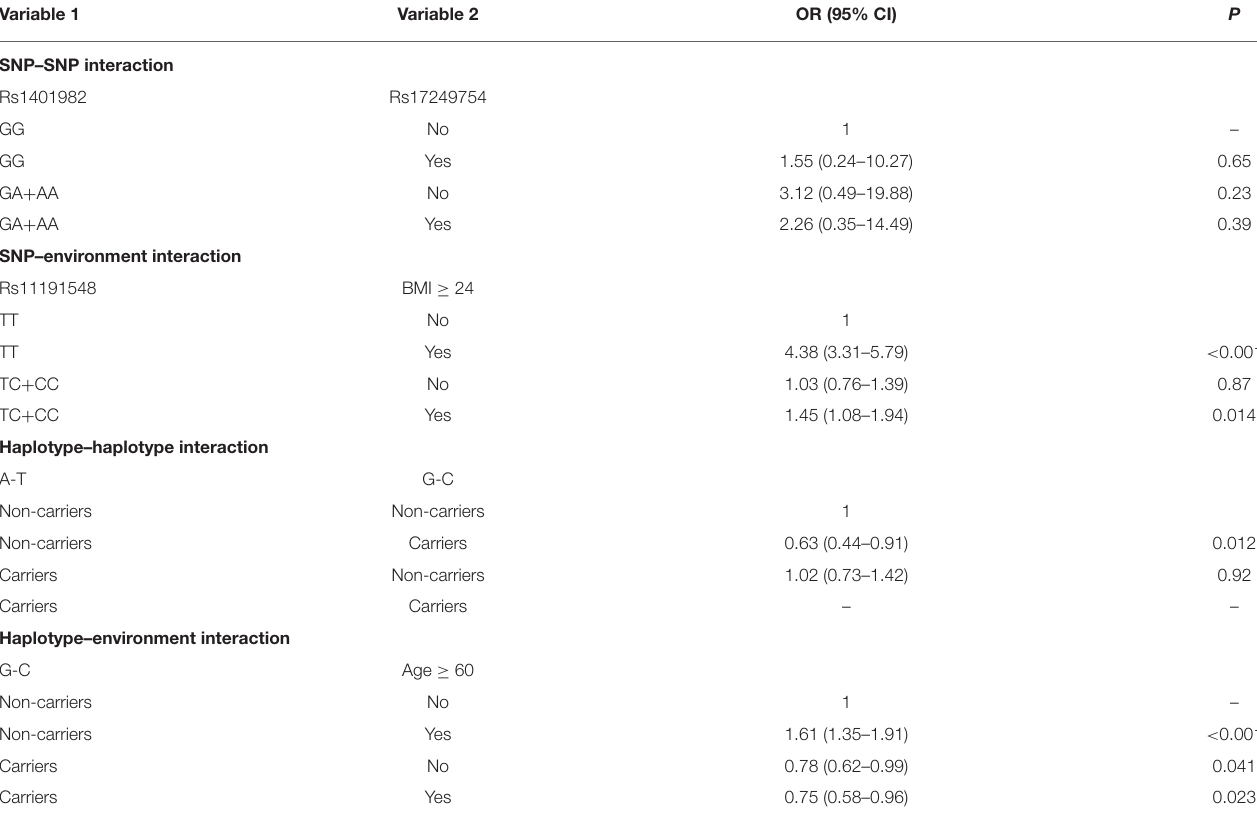
TABLE 5 | Various types of interactions were analyzed by logistic regression analysis. Variable